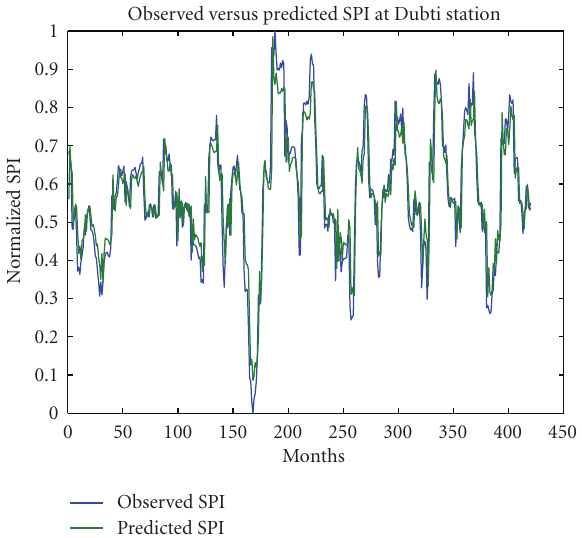
Figure 7: SPI 12 forecast results for the best ANN model at the Dubti station (1-month lead time).